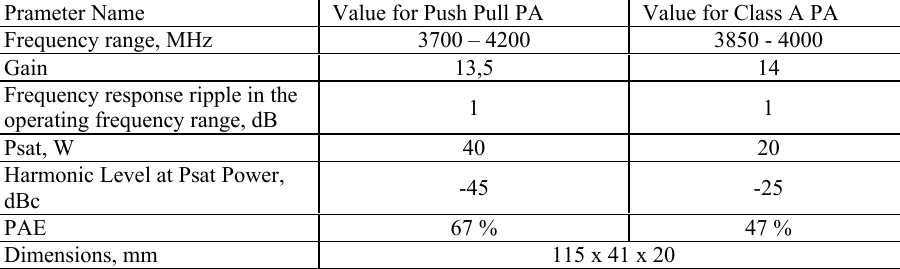
Table 1. Comparative analysis of the manufactured push-pull and class A